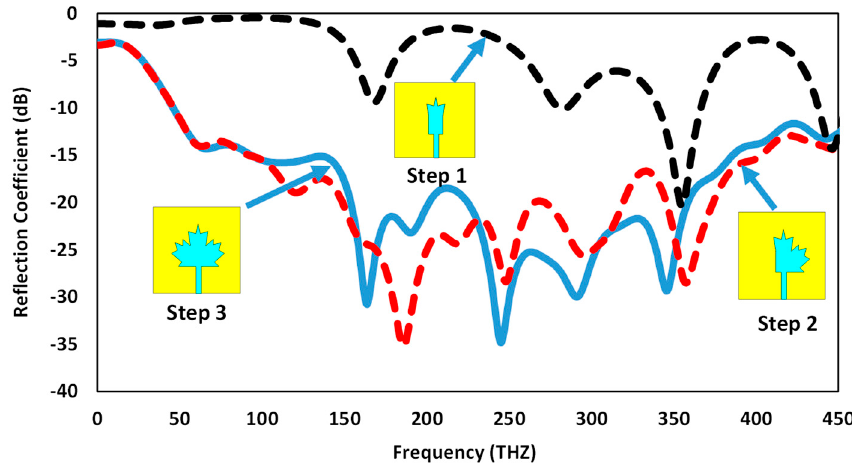
Figure 4. The S 11 of the design evaluation at each step.